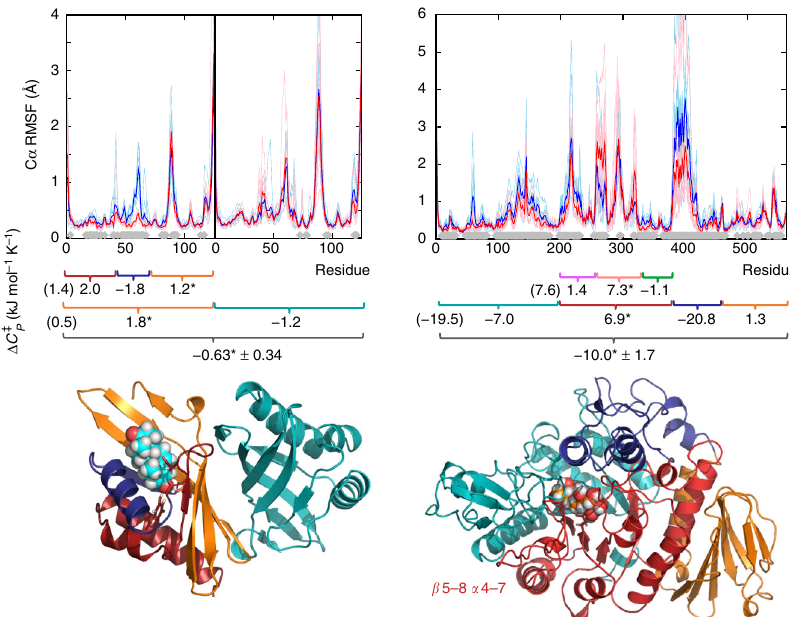
Fig. 3 Structural fl uctuations and partial heat capacity differences between reactant state and transition-state analogue complexes. Top: root-mean square fl uctuations from 50 – 500 ns MD simulations for KSI (left) and MalL (right). Thin lines are individual runs, thick lines the average of ten runs. Residues for which the C α RMSF difference between states are signi fi cant ( p < 0.01 as determined by a two-sample t -test) are indicated by grey diamonds (full data in Supplementary Fig. 7). Middle: calculated partial Δ C z P values for protein regions. Values including contribution from the ligand are indicated (*). Bottom: illustration of KSI (left) and MalL (right) coloured based on partial Δ C z P regions from the middle pane. Standard deviations are indicated for the total Δ C z P values; see Supplementary Table 5 for residue ranges and standard deviations for partial Δ C z P values. Transition-state analogues are shown with space- fi lling